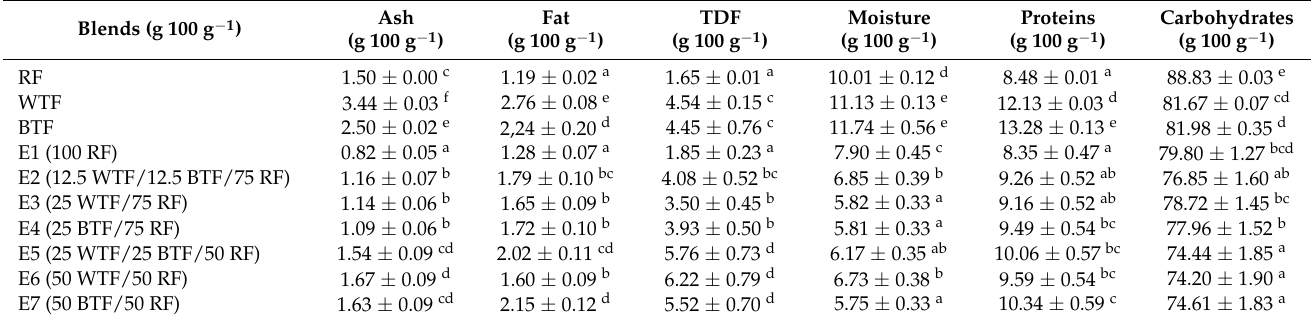
Table 2. Proximal analysis of native and extruded blend flours. The values are expressed as g 100 g − 1 of dry matter